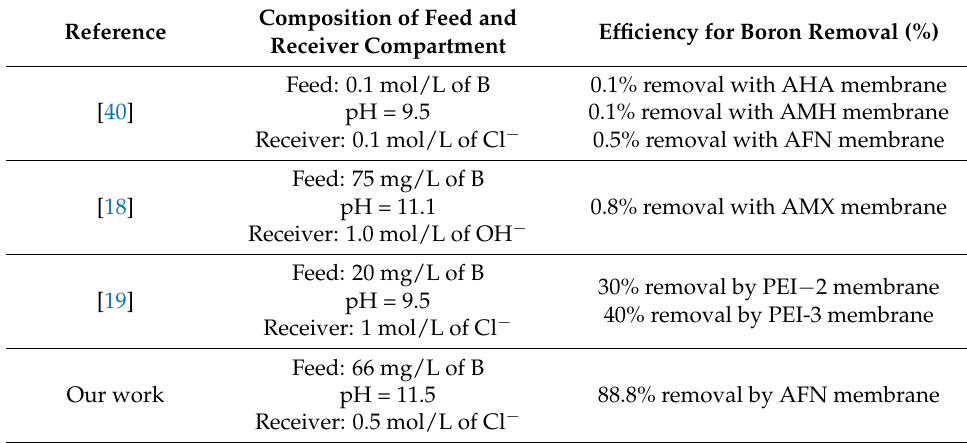
Table 8. Comparative studies of boron removal by Donnan dialysis.